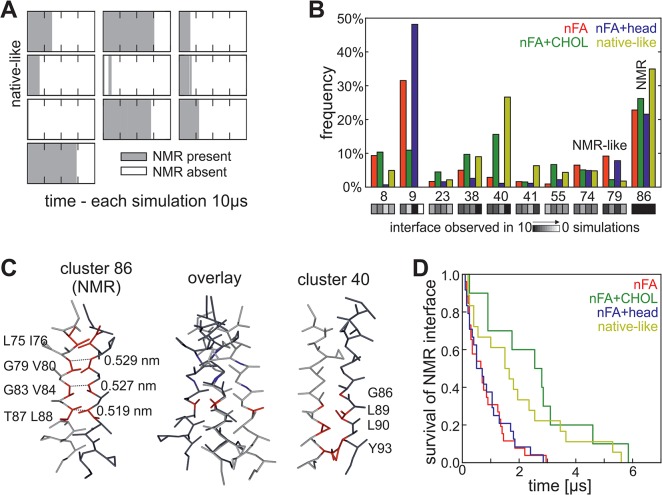
Dynamics of the protein in the RBC plasma membrane.(A) For all ten simulations of the model of the RBC plasma membrane (native-like) the presences of the NMR interface is plotted for each time point in grey. (B) Shown is the frequency of frequent interface clusters (frequency over 10% in all simulations) from all ten simulations per membrane (nFA (red), nFA+CHOL (green), nFA+head (blue), native-like (yellow)). The number of simulations, in which the corresponding interface was identified, is given on the bottom of each cluster (in grey scale). (C) Screenshot of representative structures from cluster 86 (left) and cluster 40 (right) and in the middle a structural alignment is shown. In the screenshot left and right the main interface residues are highlighted in red and in the structural alignment (cluster 86…dark grey, cluster 40…grey) the residues of the GxxxGxxxT motif are highlighted for orientation. Additionally the distances between the glycine and threonine backbone atoms of the GxxxGxxxT interface is given for the structure of cluster 86. (D) The survival time (x-axis) of the NMR interface once it appeared in the simulation (either at the start or by reformation during simulation) is plotted against the probability of the presence of the NMR interface for all four membrane systems.